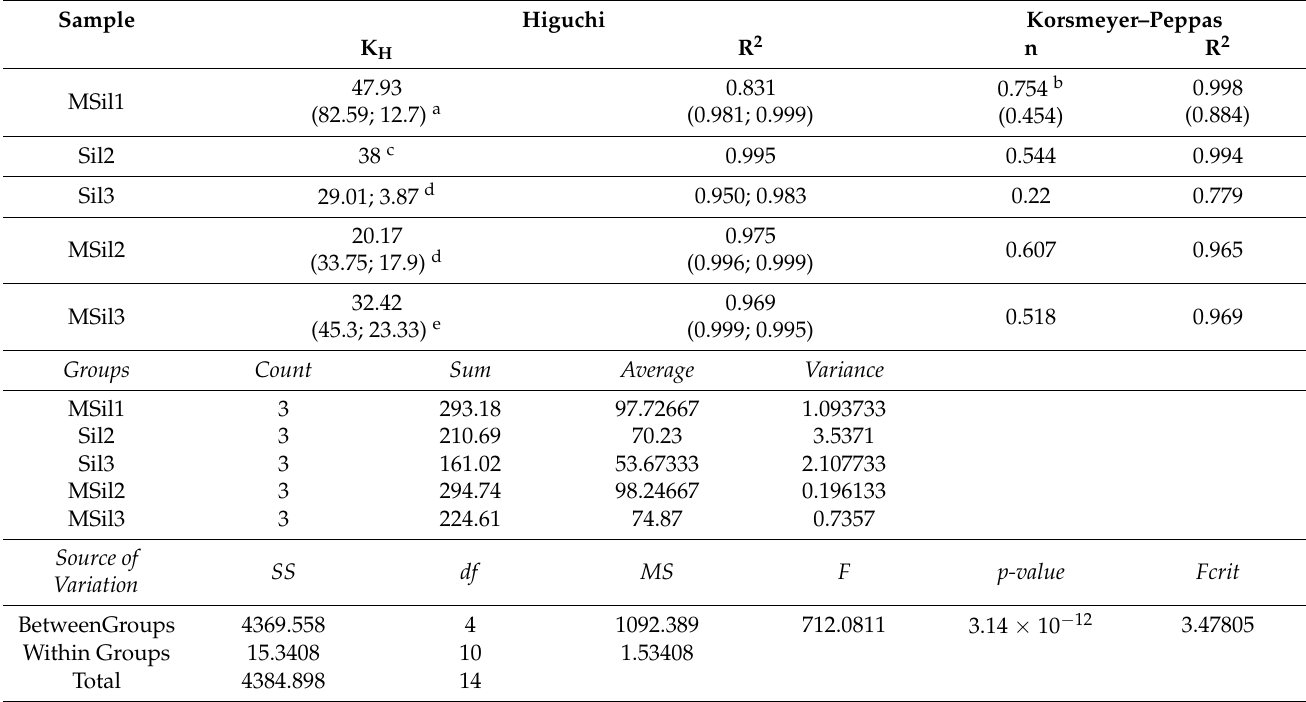
Table 7. Kinetics of Dox Release and analysis of variance (ANOVA) at pH = 5 (encapsulated from diluted